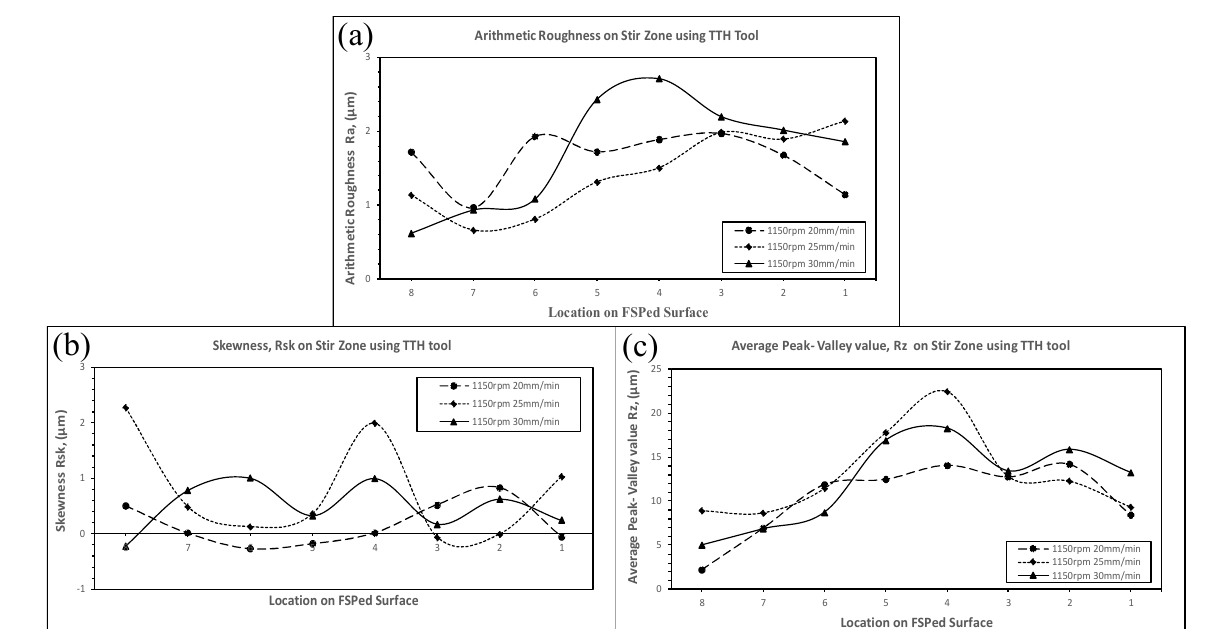
Figure 9. ( a ) Arithmetic roughness, Ra, ( b ) Skewness, Rsk, and ( c ) average peak-valley, Rz, value for FSP using 1150 rpm and TTH tool at different feed rates.